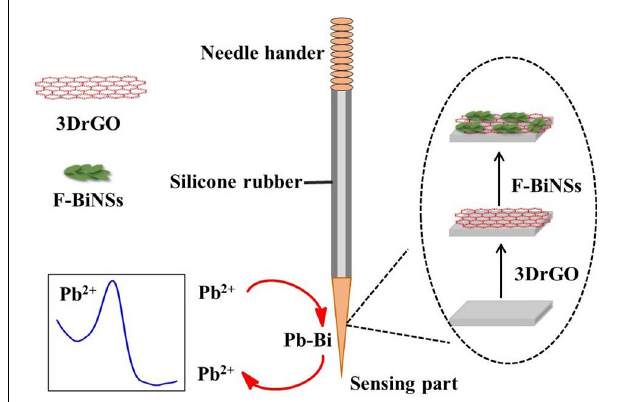
FIGURE 1 | Schematic illustration for the fabrication process of 3DrGO/F-BiNSs/ANE and the detection of Pb 2 + .